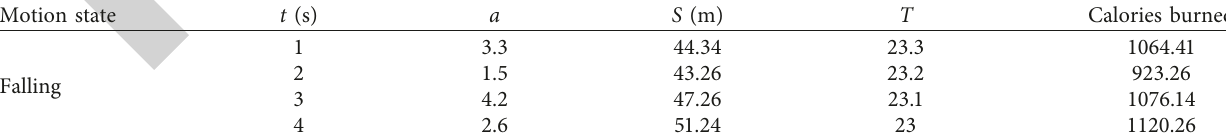
Table 5: Experimental test results of falling.